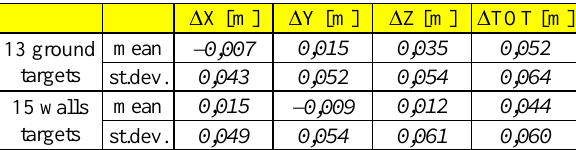
Table 13. Errors on ground/wall targets: video vs topography.